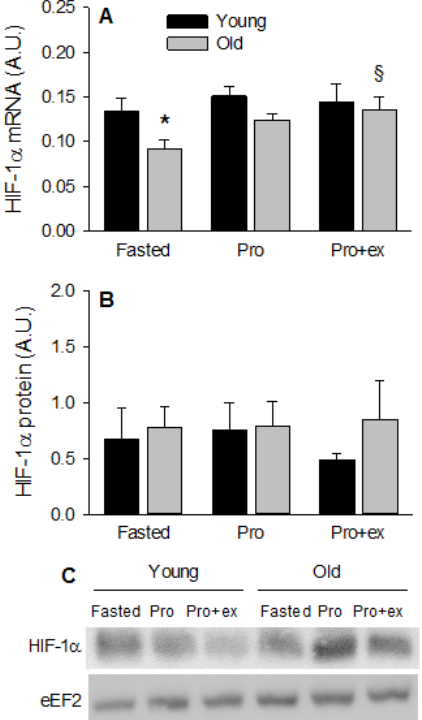
Figure 6. Effect of aging on HIF- 1α mRNA and protein expression after resistance exercise and protein intake. ( A ) HIF- 1α mRNA and ( B ) HIF- 1α protein in Fasted, Pro, and Pro+ex conditions in young and older subjects; ( C ) Representative western blots. Values are means ± SEM. § p < 0.05 vs. Fasted same age. * p < 0.05 vs. Young same condition.